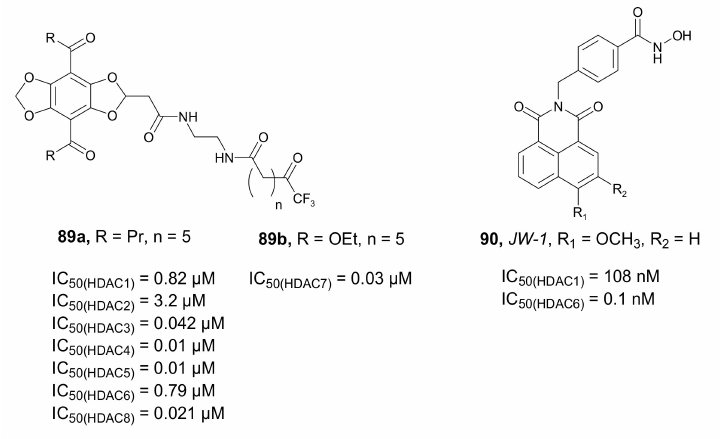
Figure 30. Chemical structures of compounds 89a – f and 90